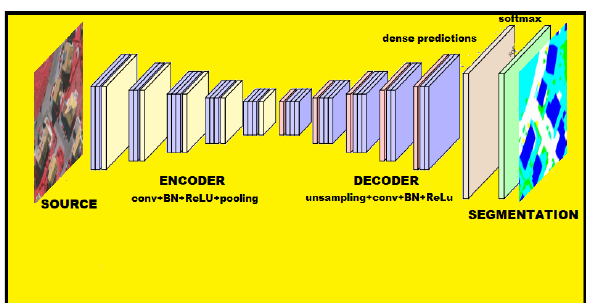
Figure 1. Semantic segmentation diagram how image is classified